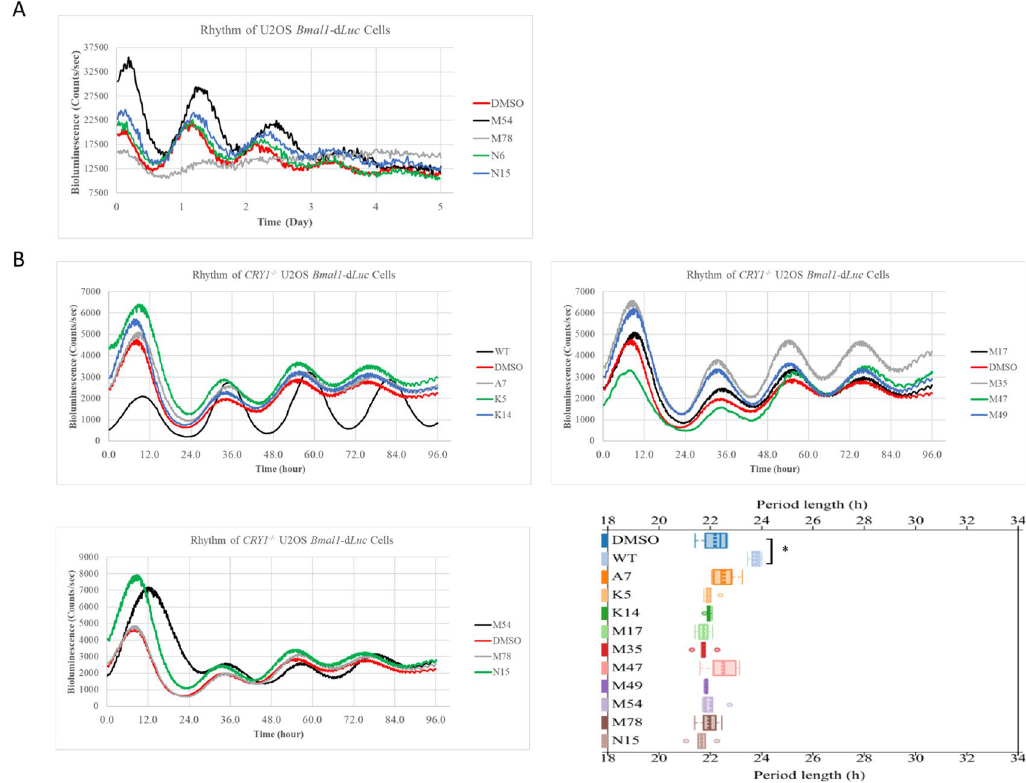
Figure 4. The effect of the molecules on circadian rhythm. ( A ) 5 × 10 4 U2OS Bmal1 -d Luc cells were seeded to an opaque 96-well plate. Next day cells were synchronized by dexamethasone for 2 h. Then the medium was replaced with luminescence recording medium having molecules or DMSO. Bioluminescence readings were recorded for a week using Synergy H1 (BioTek). Period data was calculated using Biodare2 web-server (biodare2.ed.ac.uk) (all results were given in Fig. S3). To determine molecules that are changing the period of the rhythm significantly, the period length of molecule-treated cells was compared to that of DMSO control using unpaired t-test with Welch’s correction (**** p < 0.0001 *** p = 0.001 ** p < 0.01, * p < 0.05, n = 3). Each biological replicate was the average of the 3 technical replicates. ( B ) 1 × 10 5 CRY1 -/- U2OS transduced with Bmal1- d Luc reporter. WT represents U2OS Bmal1 -d Luc. Bioluminescence readings were recorded for a week using LumiCycle (Actimetrics, USA). Period data was calculated using Biodare2 web-server (biodare2.ed.ac. uk). Unpaired t-test with Welch’s correction was used for significant analysis (* p < 0.05, n = 3). Each biological replicate was the average of the two technical Since the primary and secondary pockets of CRY1 are critical to interact with different proteins e.g. CLOCK and FBXL3, respectively, molecules designed for these two pockets might have differential impacts on the circa- dian rhythm. Thus, we focused only on the effect of 85 non-toxic molecules designed for the primary pocket of CRY1. U2OS Bmal1 -d Luc cells treated with these molecules and their effect on circadian period length was ana- lyzed by BioDare2 (biodare2.ed.ac.uk) 50 . Analysis revealed that 21 molecules significantly lengthen the period of circadian rhythm (Fig. S3). One molecule, N8, shortened the period and was excluded from further classification studies. The representative figure for period lengthener molecules is shown in Fig. 4A. Circadian rhythm results of all period lengtheners were given in Fig. S3. All period values were provided in Table S4. To verify the CRY1 dependency of molecules, we generated U2OS CRY1 -/- Bmal1 -d Luc cells by utilizing CRISPR/Cas9 technology (Fig. S4). Knocking out the CRY1 in this cell line resulted in a shorter period (indicated with red line) compared to wild-type controls (indicated with black line) as in agreement with previously published data 73 (Fig. 4B). Notably, when U2OS CRY1 -/- Bmal1 -d Luc cells were treated with potent molecules A7, K5, K14, M17, M35, M47, M49, M54, M78, and N15 no change was observed in the period length of the circadian rhythm (Fig. 4B). We, then, performed a classification study to determine the molecular characteristics leading to period change. Next, we analyzed the stability of the interaction between molecules and CRY1 using the MD simulations. The seven of the most potent (A7, M17, M35, M47, M49, M54, and M78) molecules in complex with CRY1 were simulated. Parameters for molecules were generated using CHARMM-GUI server. The CRY1-molecule complexes, obtained from docking analysis, were simulated for 20 ns. The initial docking position of molecules and nearby amino acid residues on CRY1 were shown in (Fig. 5A). We identified the nature of interactions between CRY1 and molecules as followings. Ring structures in molecules generated pi-type (Pi-cation, Pi-alkyl, Pi-Pi stacked or T-shaped) interactions with at least one of either Arg-293, His-355 and Trp-399 of CRY1. In addition, all molecules interacted with Leu-255 and Ile-392 of the CRY1 through van der Waals forces. To